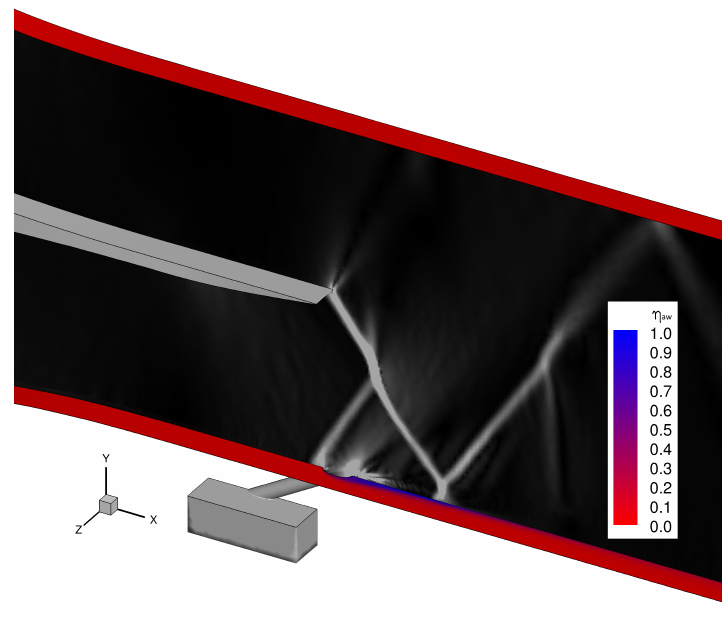
Figure 2. Main characteristics of the coolant/shock/boundary layer interaction for Ma =